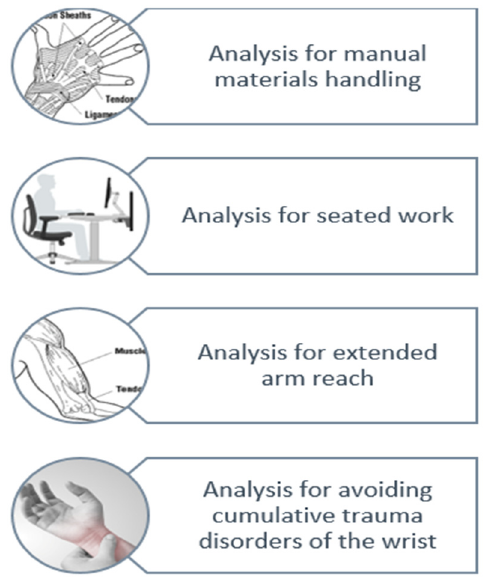
Figure 4. Main risk factors to analyze in order to avoid ergonomic hazards into workplace.